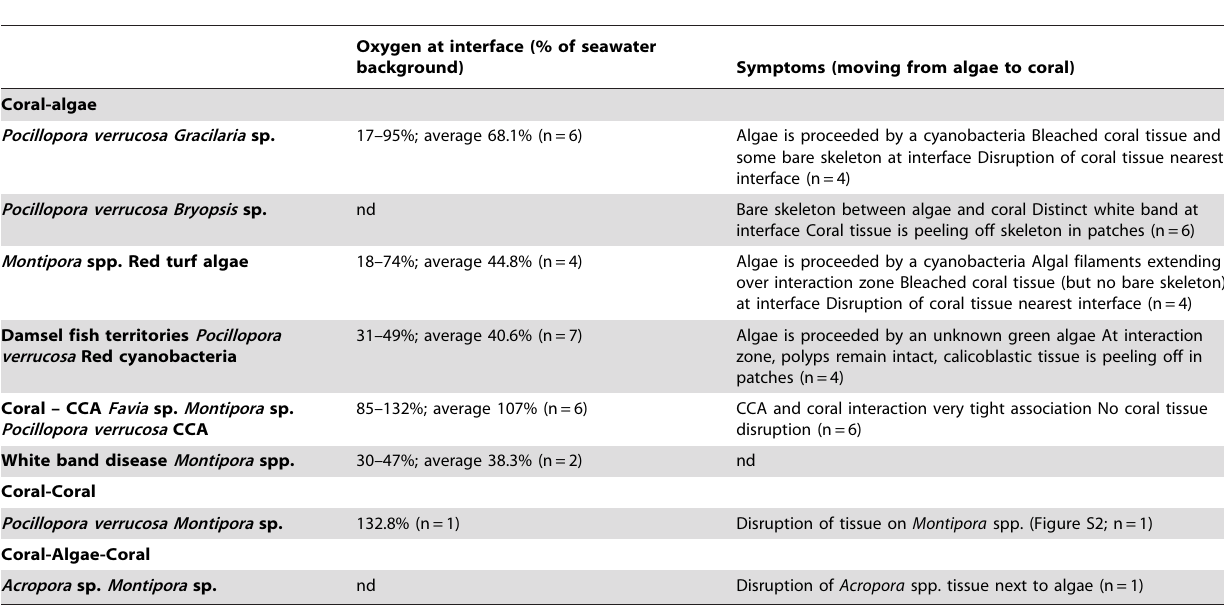
Table 1. Summary of oxygen microprobing and symptoms from hyperspectral images from coral-algae and coral-coral boundaries in the Southern Line